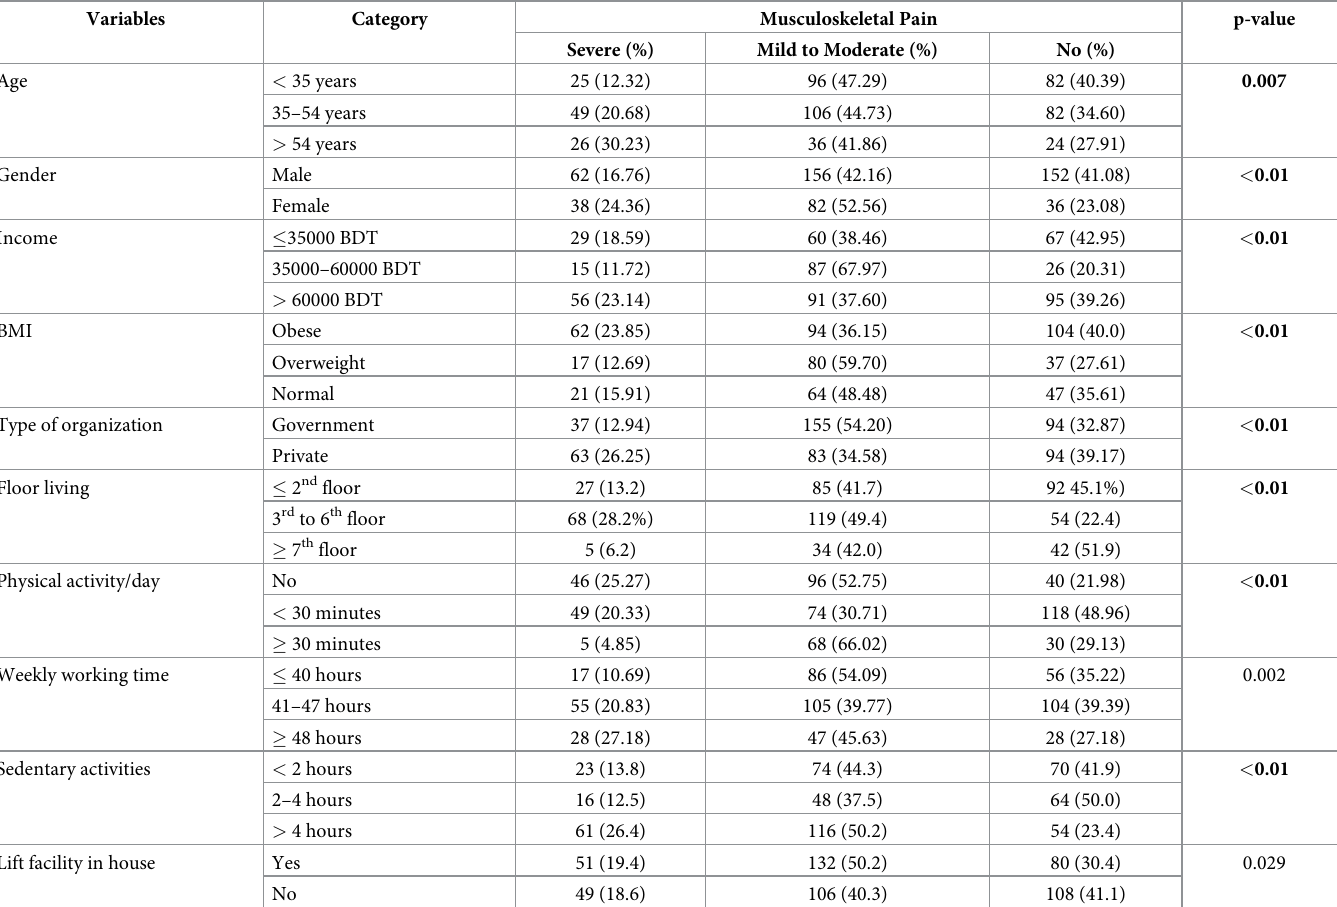
Table 1. Association of socio-demographic characteristics and activity related characteristics with MS